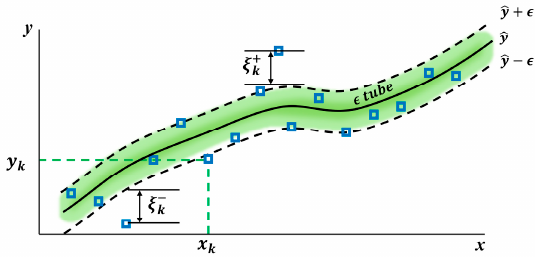
Figure 2. The definition of ε , k ξ + and k ξ − for support vector regression.